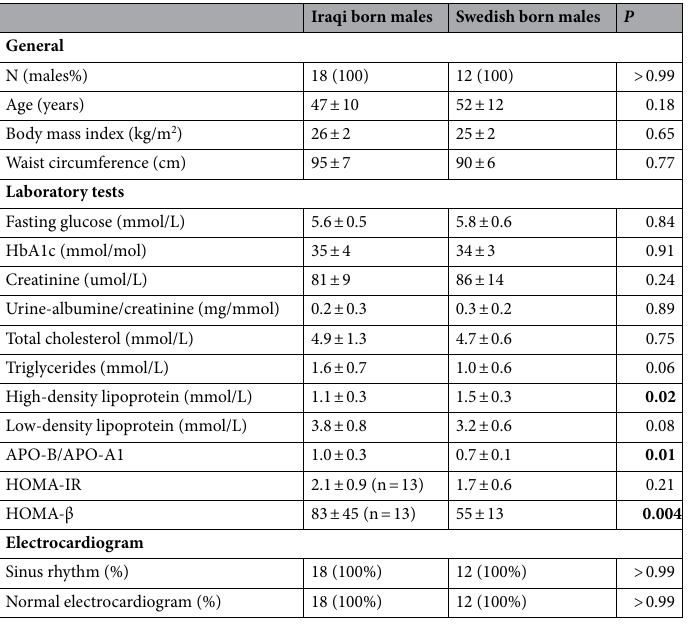
Table 1. Baseline characteristics of study participants. HbA1c hemoglobin A1c, APO-B apolipoprotein-B, APO-A1 apolipoprotein-A1, HOMA-IR homeostatic model assessment for insulin resistance, HOMA-β homeostatic model assessment of β-cell function. Significant values are given in bold.